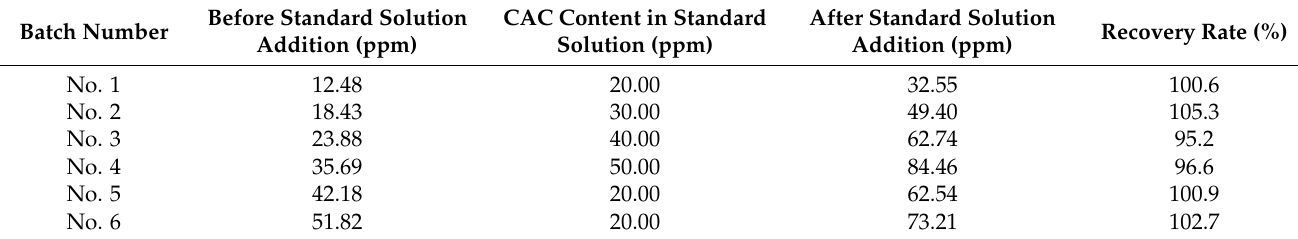
Table 3. The standard recovery rate for CAC